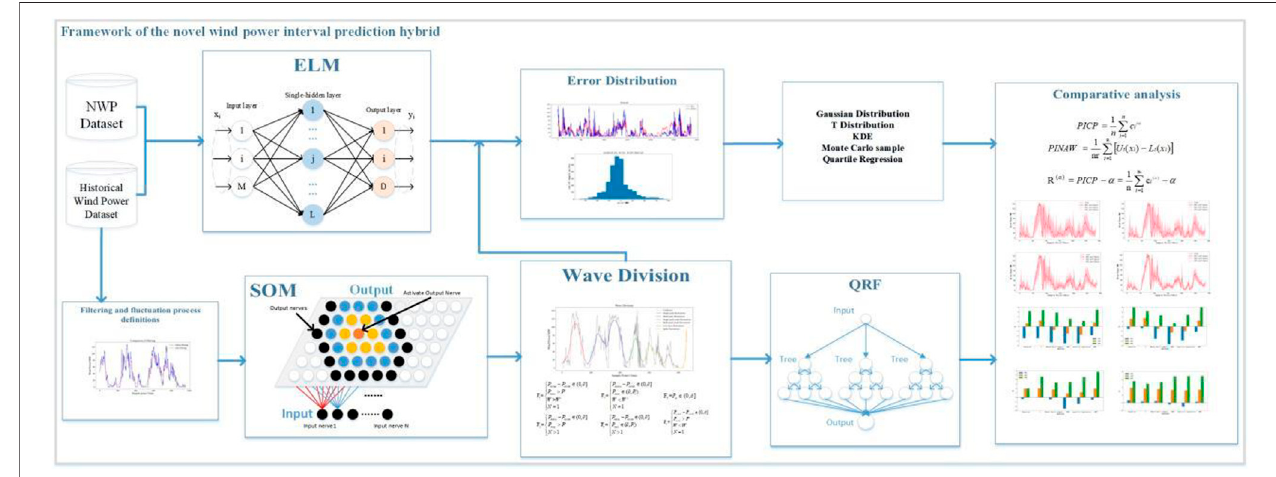
FIGURE 1 | The framework of the proposed combined prediction.